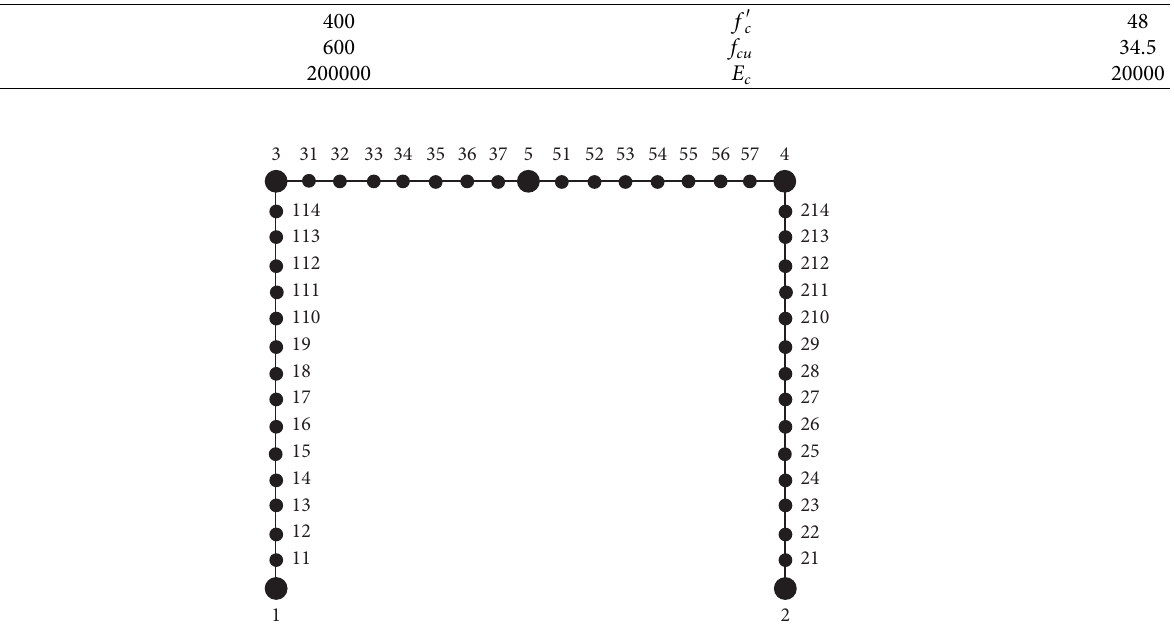
Figure 4: Finite element model.